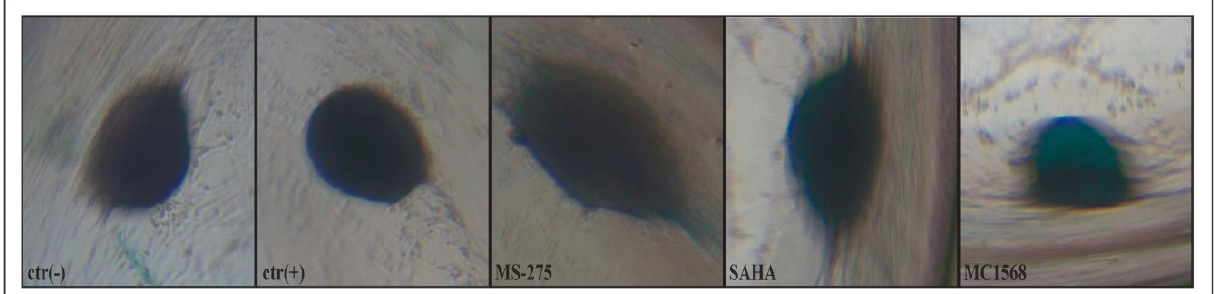
Figure 2. Alcian blue assay performed after 21 days of inductions [ctr( − ), ctr(+), MS-275 , SAHA , and MC1568 ] for the detection of the GAGs present in the three-dimensional structures formed by the condensation of the hMSCs.